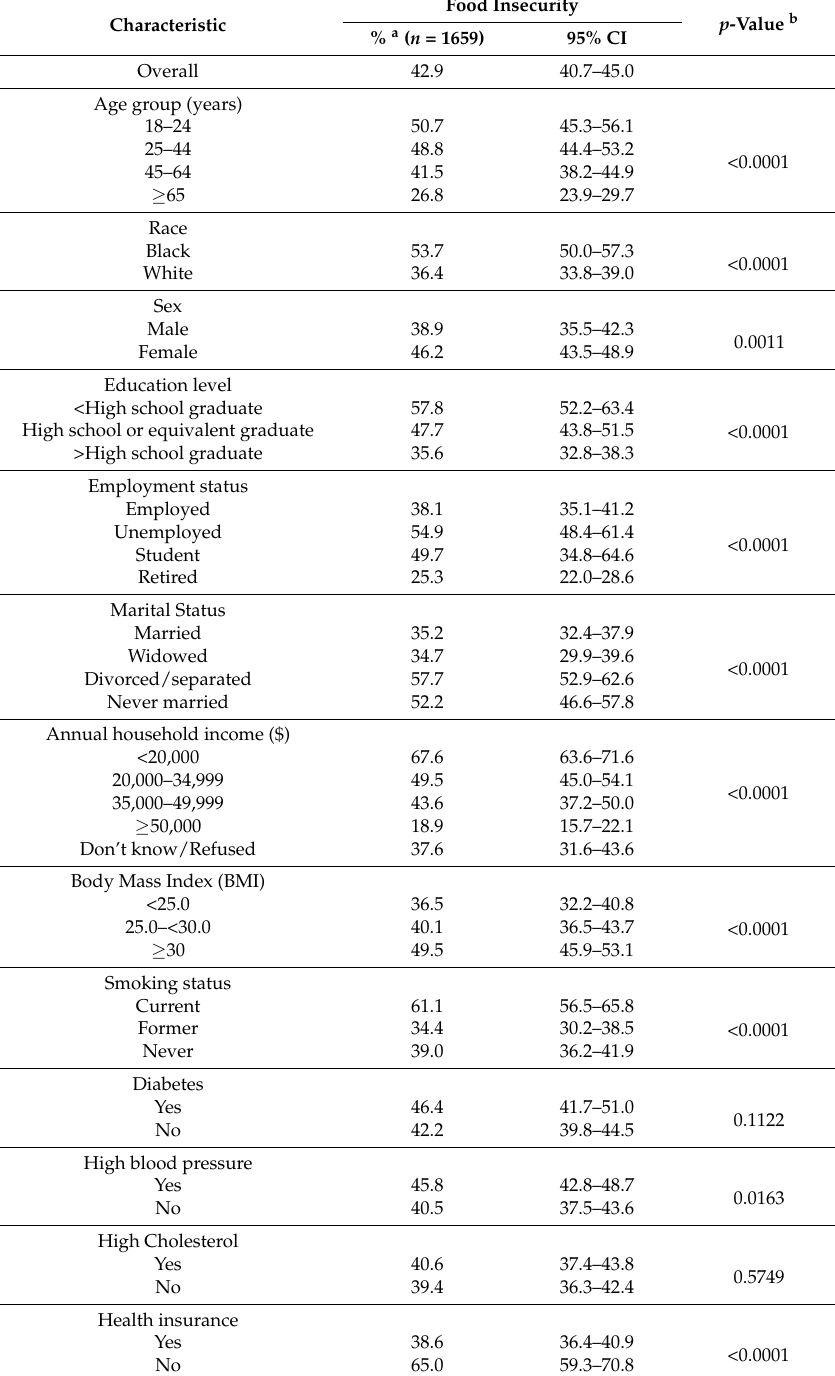
Table 2. Food insecurity among Mississippi adults by sociodemographic and health characteristics, Behavioral Risk Factor Surveillance System,